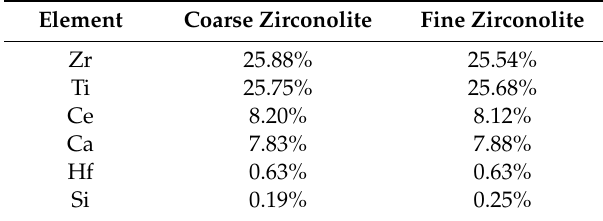
Table 2. Major elements ( > 0.1 wt%) in the zirconolite feed samples.